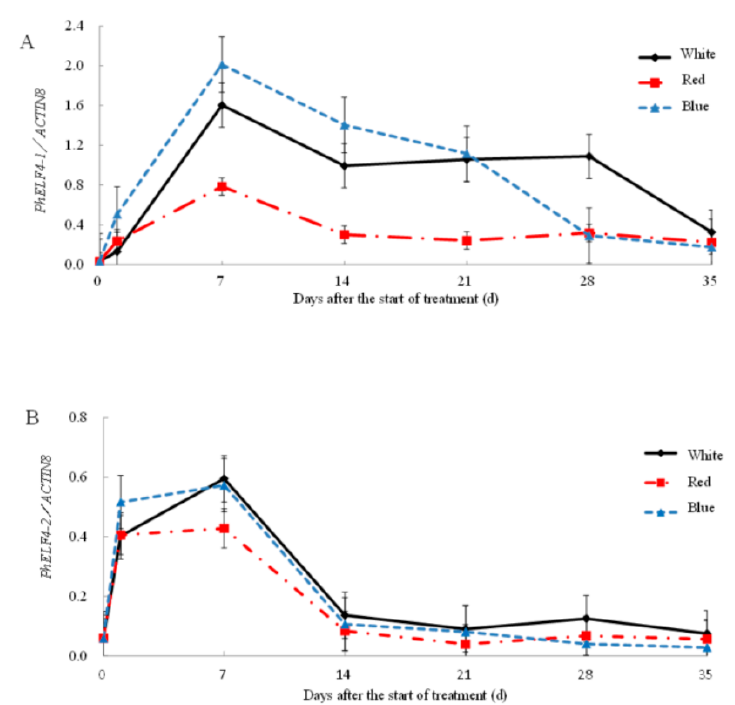
Figure 4. Expression of PhELF4-1 ( A ) PhELF4-2 ( B ) in young leaves of petunia plants grown under white fluorescent light or blue or red light from light emitting diodes under long days of a 14 h photoperiod, as analyzed by real-time quantitative PCR. All leaves were sampled after 12 h of lighting at each sampling day. The expression was normalized to the expression of the PhACTIN 8 gene. The error bars show SE ( n =